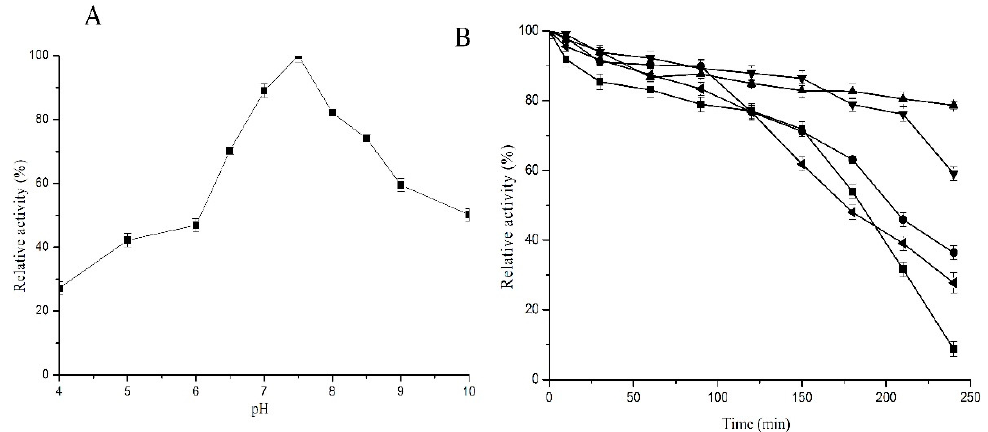
Figure 2. Optimum pH and pH stability of C12O from Pc UFB2. ( A ) 0.13 µ g of enzyme incubated at different pH and assayed for enzyme activity; ( B ) pH stability profile of C12O at pH 4 ( (cid:4) ), pH 6 ( ), pH 7( (cid:72) ), pH 8 ( (cid:78) ), and pH 10 ( (cid:16)